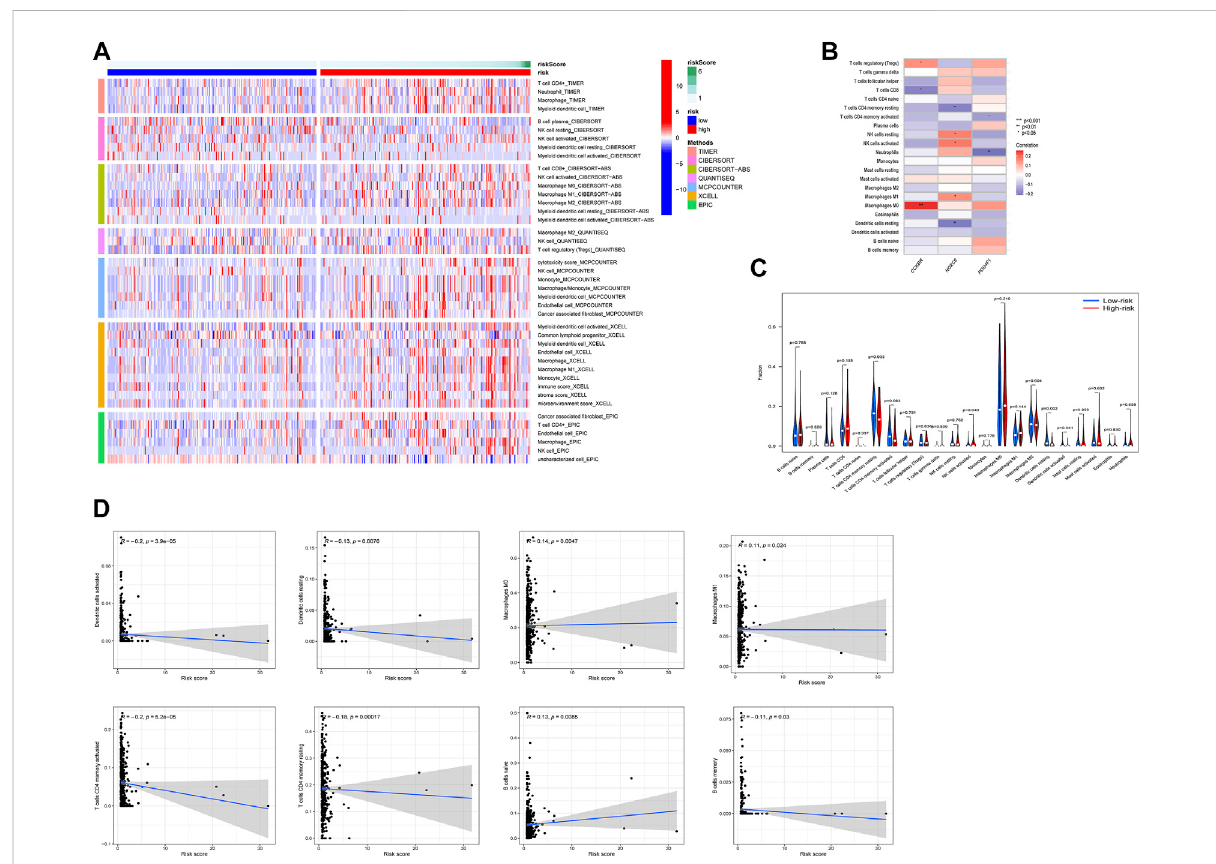
FIGURE 6 Relationship between risk score and tumor-in fi ltration immune cells in high-risk and low-risk groups. (A) The in fi ltration of TIICs was assessed by multiple databases (TIMER, CIBERSORT, CIBERSORT-ABS, QUANTISEQ, MCPCOUNTER, XCELL, and EPIC). (B) The relation between the expression of 3 ERGs and immunecell in fi ltration. (C,D) Comparison of TIICs and the association betweenrisk score and TIICs. * p < 0.05, ** p < 0.01, *** p <